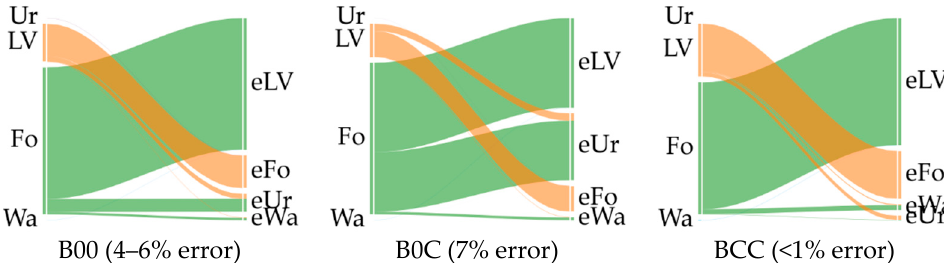
Figure 11. Alluvial diagrams of the errors as a function of predictor variables used for classification at the tropical site. Left vertical axes show the reference label (Ur, Urban, in purple; LV, low vegetation, in orange; Fo, forest, in green; Wa, water, in blue), right vertical axes show classified label for the misclassified (error—‘e’) pixels. The thickness of the lines indicates error frequency compared to the total error.